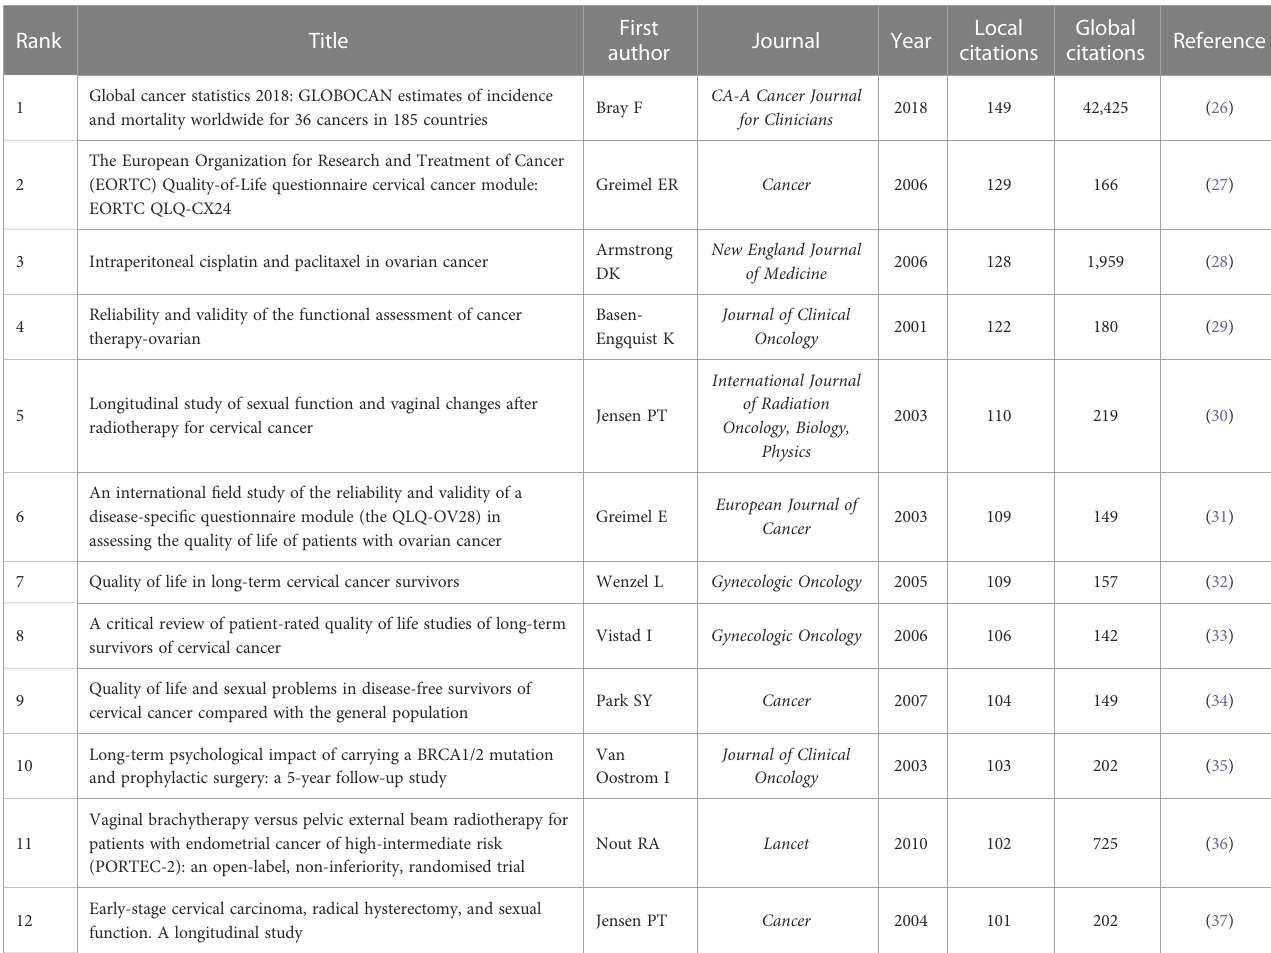
TABLE 4 Top 20 locally cited publications in QoL or mental health of gynecologic oncology patients.